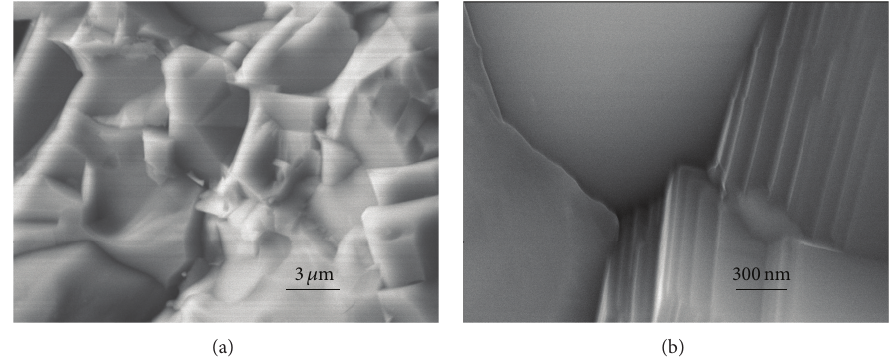
Figure 6: FESEM fracture morphologies in the coarsened irregular TiC grains: (a) fracture surface in TiC grains, (b) the cleavage surface and tearing ridge.